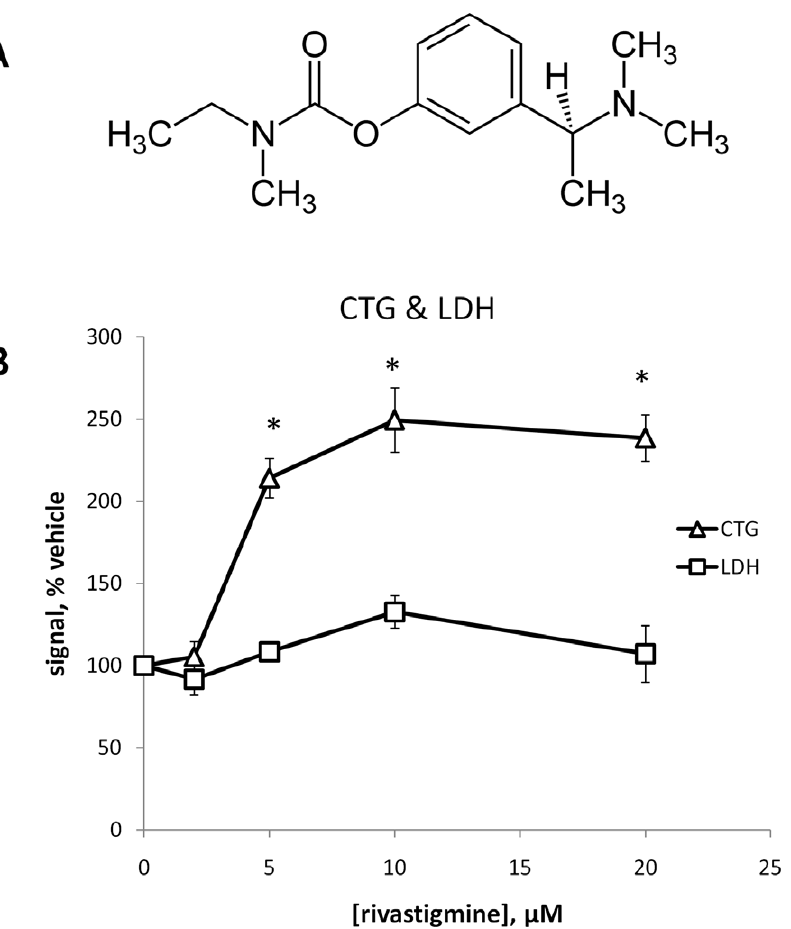
Figure 3. Rivastigmine enhances cell viability in neurodegenerating primary cultures. A : Rivastigmine is a parasympathomimetic cholinergic agent used for the treatment of mild to moderate AD. Its systematic (IUPAC) name is (S)-N-Ethyl-N-methyl-3-[1-(dimethylamino)ethyl]- phenyl carbamate. B : Primary cultures were treated with rivastigmine at the indicated concentrations for 4 days starting at day 12, and were then subjected to the Cell Titer-Glo (CTG) assay to assess cell viability and metabolic activity. Significant increases in ATP concentrations were observed in the lysates of cells treated with 5 m M, 10 m M and 20 m M rivastigmine (both p , 0.05), while no effect was observed with 2 m M rivastigmine. The potential of drug-induced toxicity was assessed by measuring LDH release, but no significant difference from vehicle was observed, suggesting that all rivastigmine doses were well tolerated.